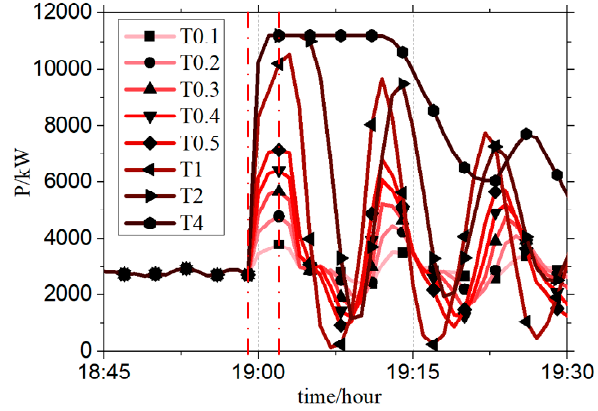
Figure 8. The load rebound of the aggregate model.